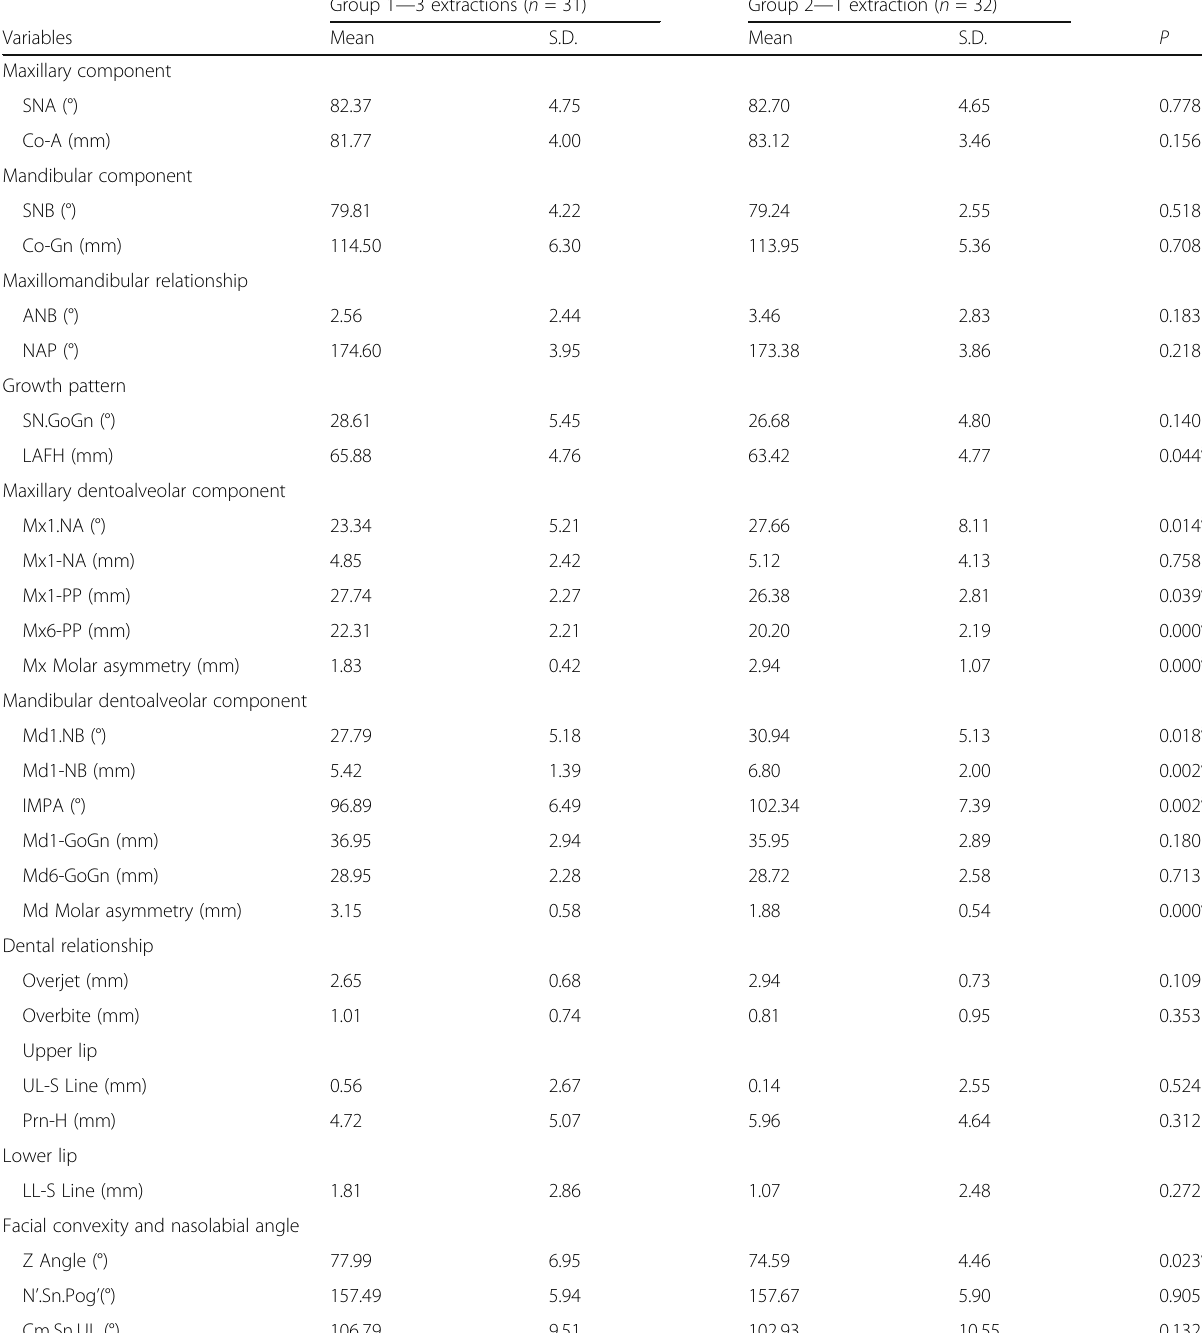
Table 5 Intergroup comparison at the posttreatment stage ( t tests) Group 1 — 3 extractions ( n =